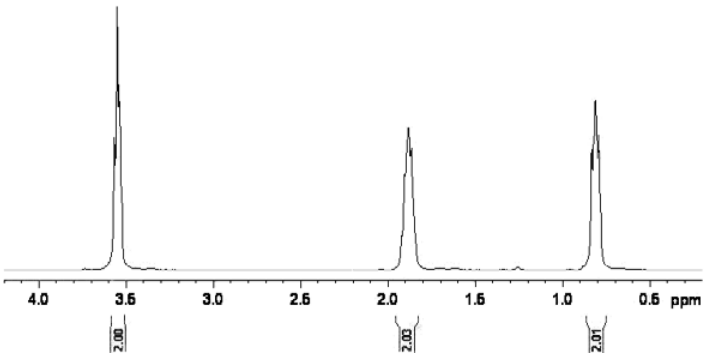
Fig. 1. 1 H NMR spectrum of